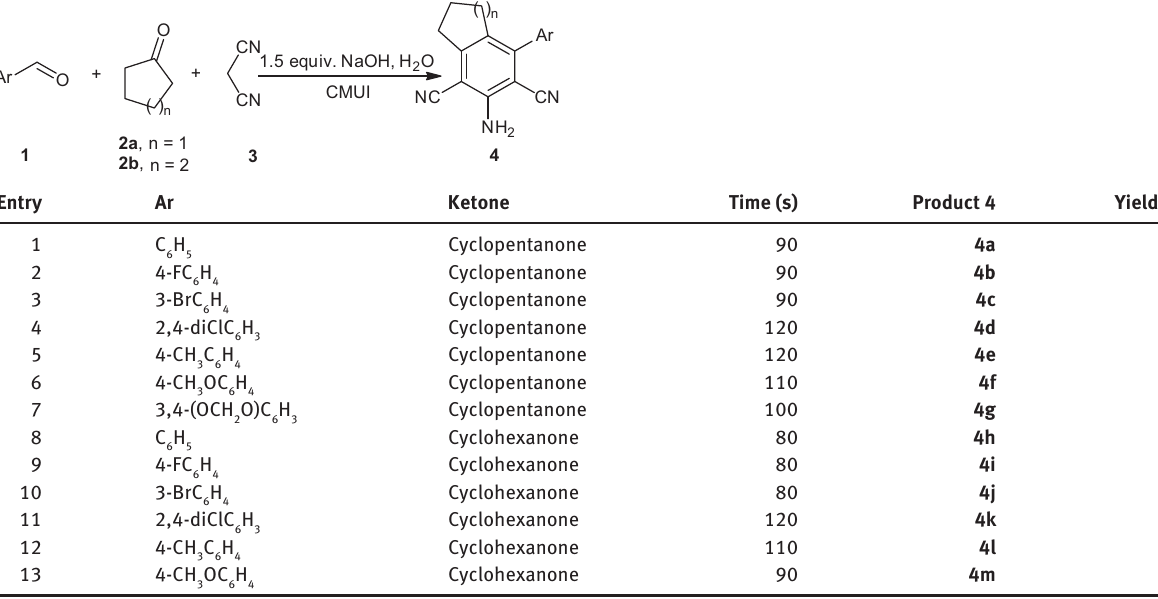
Table 2 Synthesis of polysubstituted 3-aryl-2,6-dicyanoanilines under CMUI. a